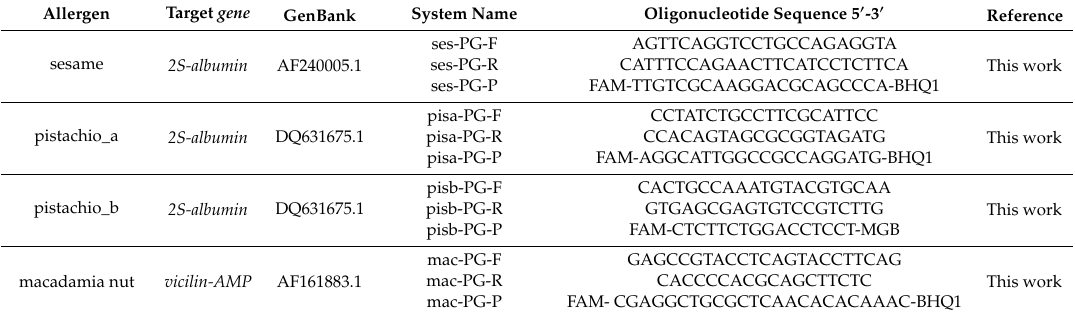
Table 1. Target genes and sequence